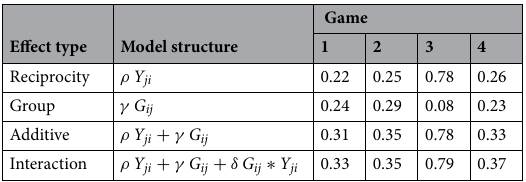
2 Table 2. R for models for the full game.